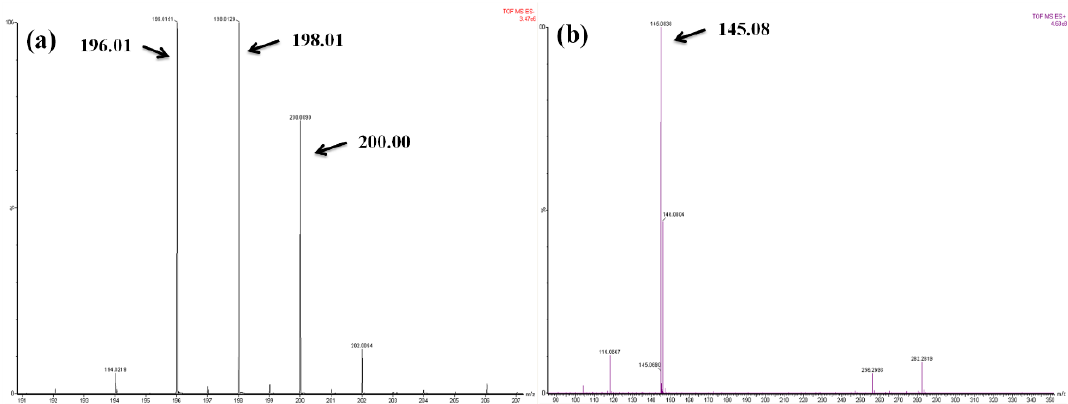
Figure 1. Mass spectrum (ionization source: electrospray ionization) of Brønsted/Lewis magnetic ionic liquid (B-L MIL) 5a. ( a ) Anion and ( b ) cation fragments.